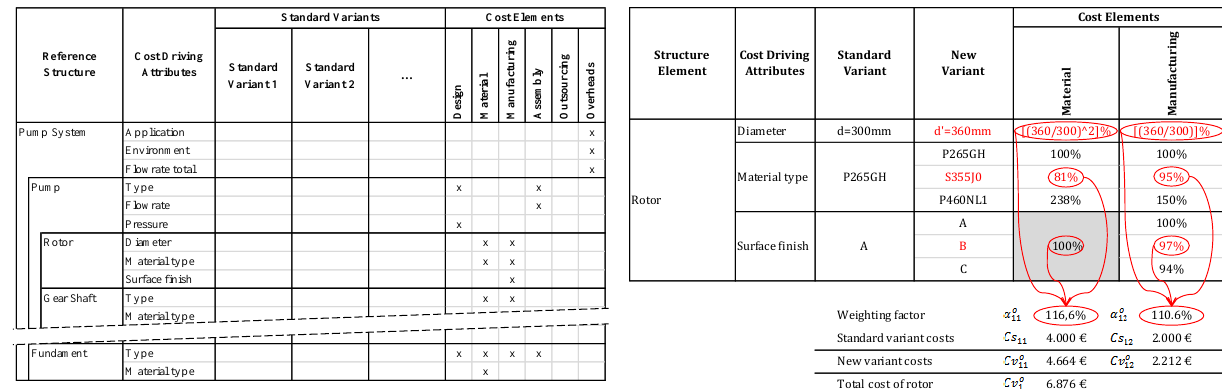
Table 1: Reference structure vs. cost elements.